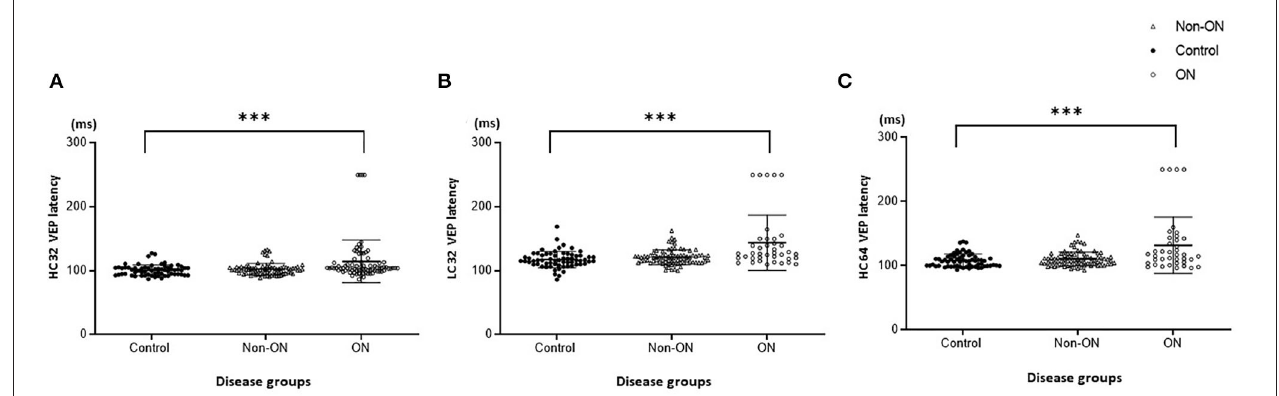
FIGURE 1 | Visual evoked potential (VEP) latency with high-contrast (HC, 100%) and low-contrast (LC, 10%) stimulation. (A) HC32 VEP for patients without optic neuritis (ON) or with first-ever ON and healthy controls. (B) LC32 VEP for patients without ON or with first-ever ON and healthy controls. (C) HC16 VEP for patients without ON or with first-ever ON and healthy controls. *** p <